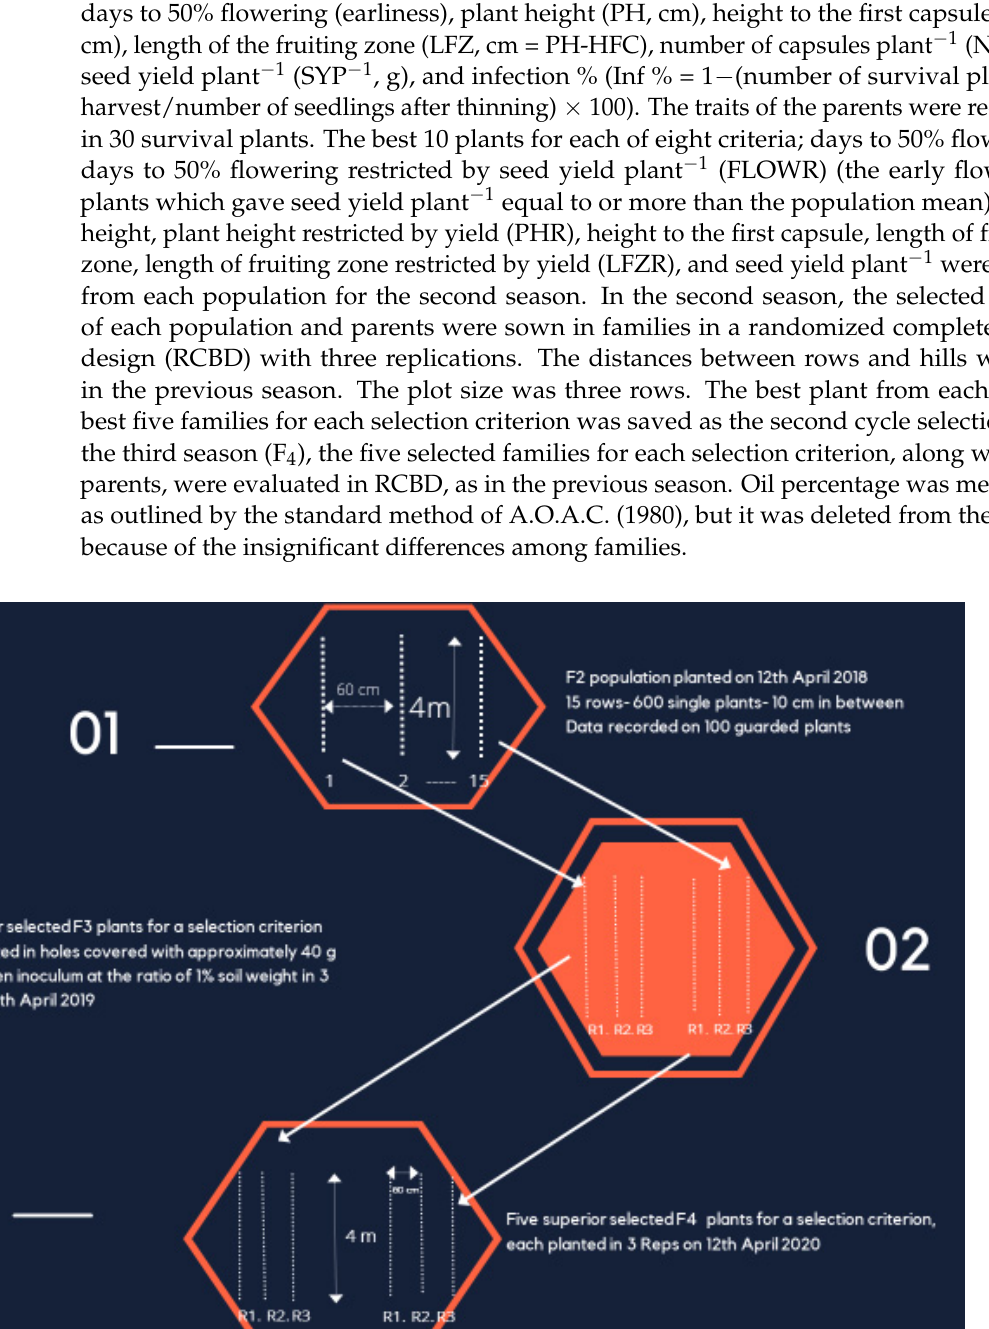
Fusarium oxysporum f. sp. sesami (Zap) Cast. was isolated from sesame plants showing symptoms of wilt. Diseased tissues were cut into small pieces (2–3 mm), washed thor ‐ oughly with tap water, the surface was sterilized with 3% NaOCL for 3 min, and washed two times with sterilized water. The sterilized pieces were cultured in Potato Dextrose Agar (PDA) and incubated for 3–5 days. Identification of the isolated fungi was carried out on 5–12 ‐ day ‐ old culture, using the morphological and microscopic characteristics of mycelium and spores according to [12]. During planting, sesame seeds were dibbled in holes and covered with an equal amount (approximately 40 g) of pathogen inoculum at a ratio of 1% soil weight. 4.3. Statistical Analysis The analysis of variance (ANOVA), and phenotypic ( σ 2 p) and genotypic variance ( σ 2 g) were performed as in [34]. The analysis of variance was performed twice. The first was for all entries (selected families + parents), the second was for the selected families only, to estimate coefficients of variation and heritability (not included), as these should be calculated without the parents. The analysis of variance of the infection percentage was carried out on Arcsine transformed data. Genotypic variance ( σ 2 g) = (Msg − MSe)/r Phenotypic variance ( σ 2 g) = σ 2 g + MSe/r